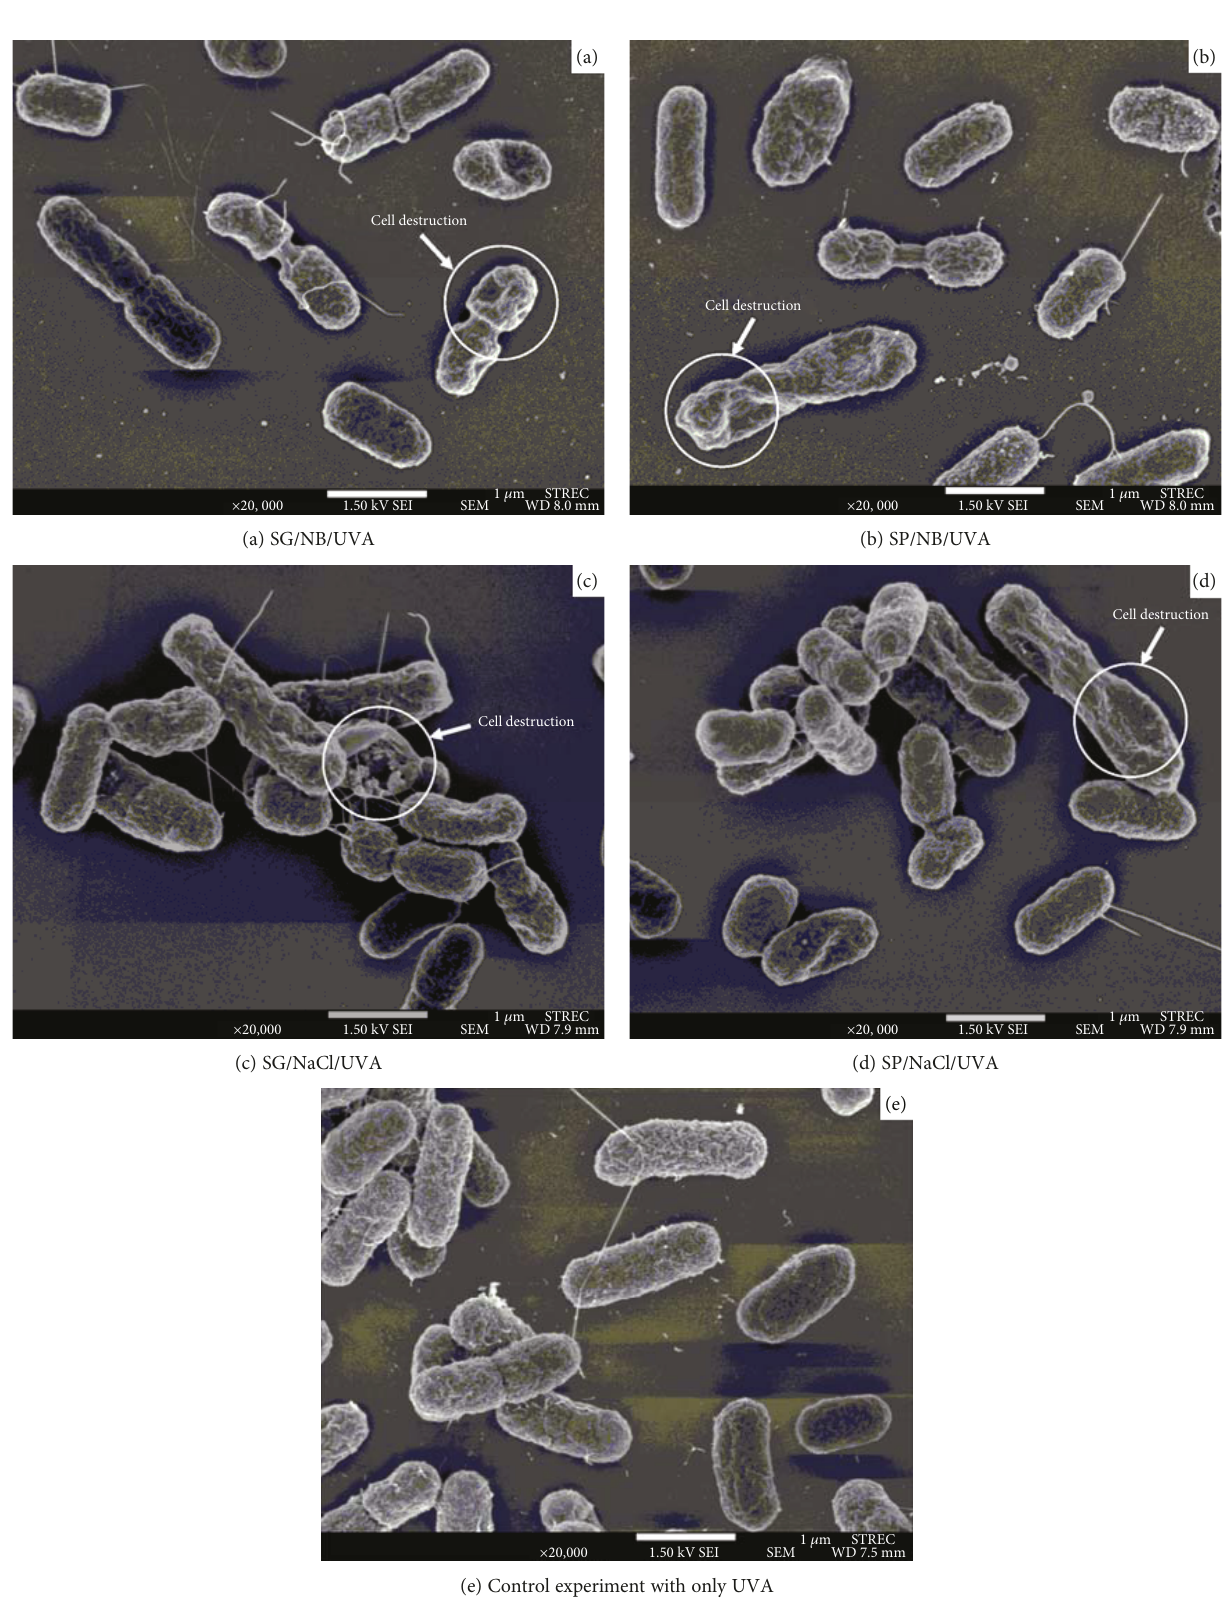
Figure 9: The FE-SEM images of E. coli in NB and 0.85% NaCl after 180 minutes treated with the SG- and SP-TiO irradiation vis-à-vis the control, given the initial bacterial concentration of 10 4 CFU · mL − 1